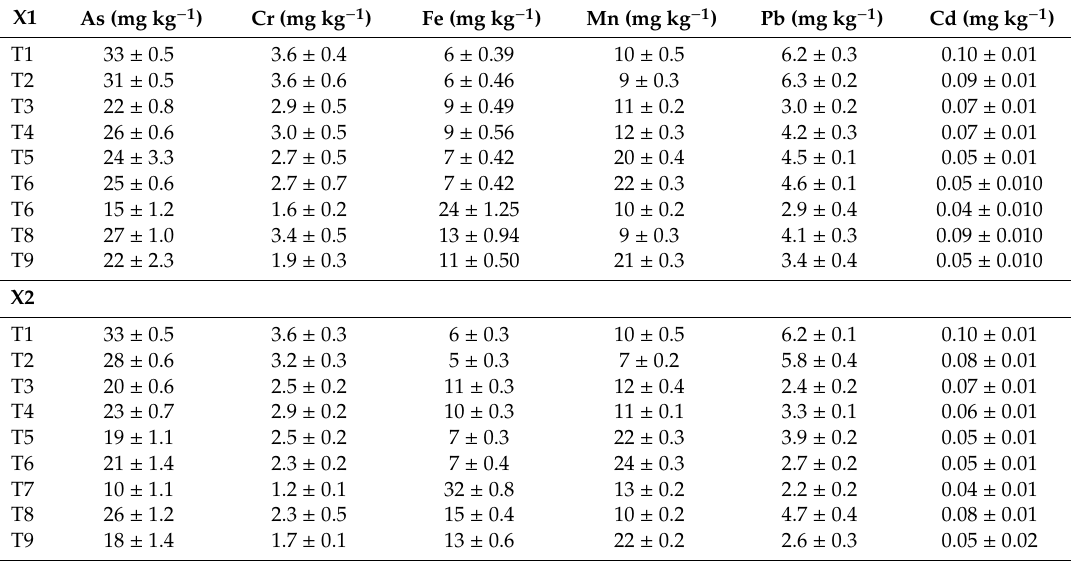
Table 4. Mean value and standard error of extractable elements (mg kg − 1 ) in the